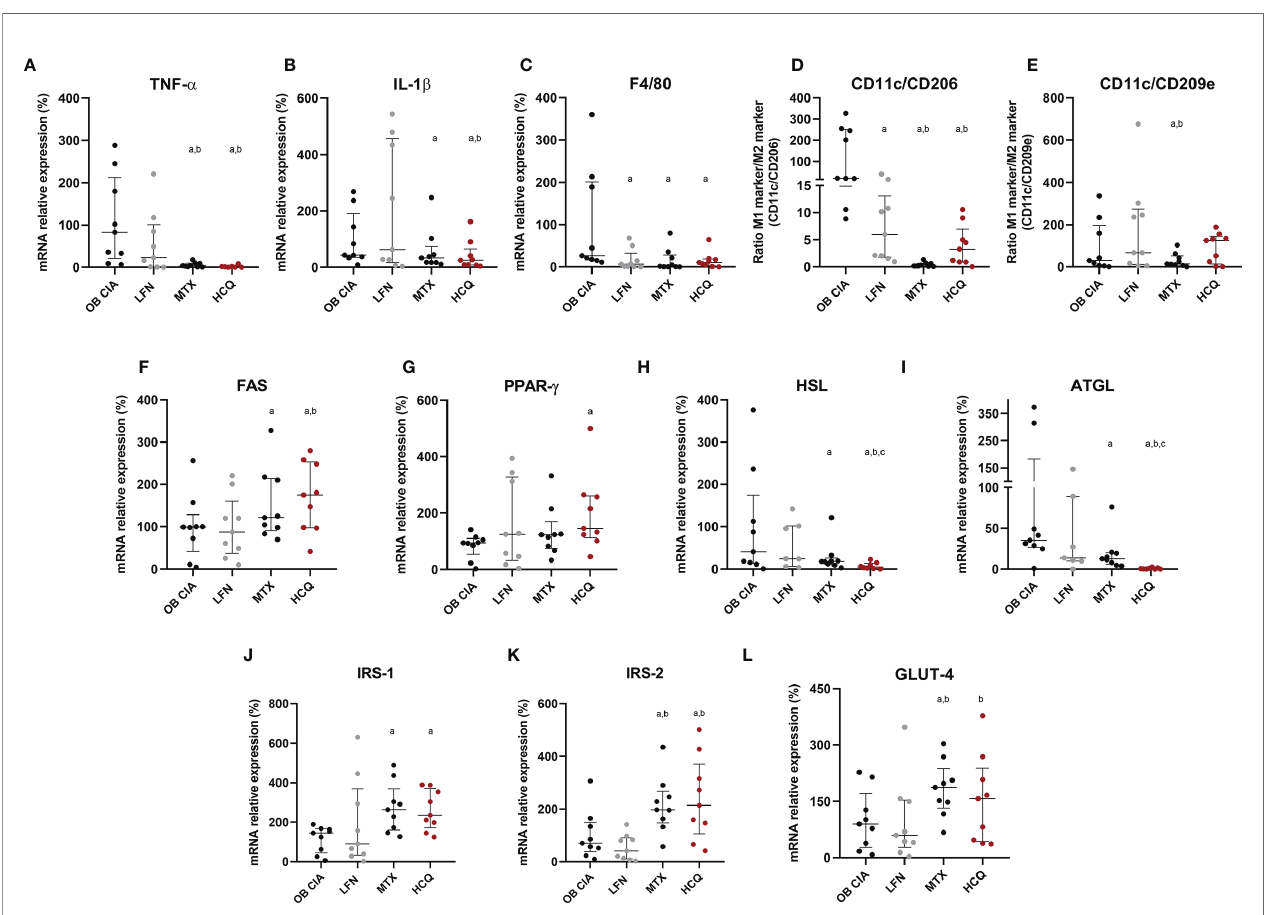
FIGURE 5 | Molecular effects of cDMARDs in white adipose tissue of OB CIA mice. (A) mRNA relative expression of TNF- a in white adipose tissue of OB CIA mice after 14 days of treatment with LFN, MTX, and HCQ. (B) mRNA relative expression of IL-1 b in white adipose tissue of OB CIA mice after 14 days of treatment with LFN, MTX, and HCQ. (C) mRNA relative expression of F4/80 in white adipose tissue of OB CIA mice after 14 days of treatment with LFN, MTX, and HCQ. (D) ratio of CD11c/CD206 mRNA relative expression in white adipose tissue of OB CIA mice after 14 days of treatment with LFN, MTX, and HCQ. (E) ratio of CD11c/CD209e mRNA relative expression in white adipose tissue of OB CIA mice after 14 days of treatment with LFN, MTX, and HCQ. (F) mRNA relative expression of FAS in white adipose tissue of OB CIA mice after 14 days of treatment with LFN, MTX, and HCQ. (G) mRNA relative expression of PPARg in white adipose tissue of OB CIA mice after 14 days of treatment with LFN, MTX, and HCQ. (H) mRNA relative expression of HSL in white adipose tissue of OB CIA mice after 14 days of treatment with LFN, MTX, and HCQ. (I) mRNA relative expression of ATGL in white adipose tissue of OB CIA mice after 14 days of treatment with LFN, MTX, and HCQ. (J) mRNA relative expression of IRS-1 in white adipose tissue of OB CIA mice after 14 days of treatment with LFN, MTX, and HCQ. (K) mRNA relative expression of IRS-2 in white adipose tissue of OB CIA mice after 14 days of treatment with LFN, MTX, and HCQ. (L) mRNA relative expression of GLUT-4 in white adipose tissue of OB CIA mice after 14 days of treatment with LFN, MTX, and HCQ. OB, obese; CIA, collagen-induced arthritis; LFN, le fl unomide; MTX, methotrexate; HCQ, hydroxychloroquine; TNF- a , tumor necrosis factor alpha; IL-1 b , interleukin 1 beta; F4/80, cell surface glycoprotein F4/80; CD, cluster differentiation; FAS, fatty acid synthase; PPAR g , peroxisome proliferator activated receptor gamma; HSL, hormone sensitive lipase; ATGL, adipose triglyceride lipase; IRS-1, insulin receptor substrate 1; IRS-2, insulin receptor substrate 2; GLUT-4, glucose transporter type 4. Signi fi cance was determined by one-way ANOVA followed by Ducan post hoc test. a Signi fi cant differences vs. OB CIA (p < 0.05). b Signi fi cant differences vs. LFN (p < 0.05). c Signi fi cant differences vs. MTX (p <